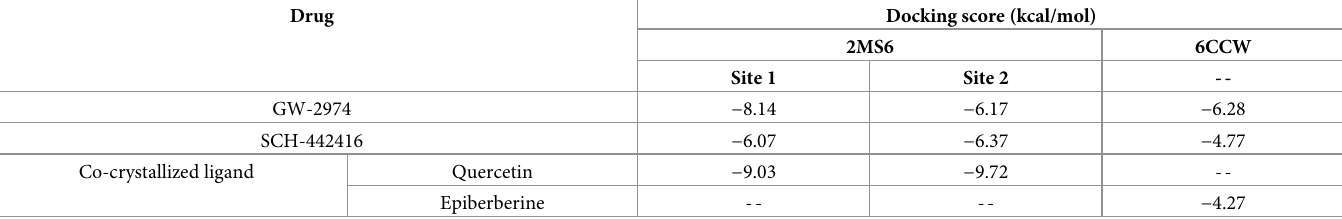
Table 3. Docking scores of GW-2974, SCH-442416 and the co-crystallized drugs (quercetin and epiberberine) into the binding sites of the parallel (2MS6) and the hybrid (6CCW) human telomeric G-quadruplex DNA